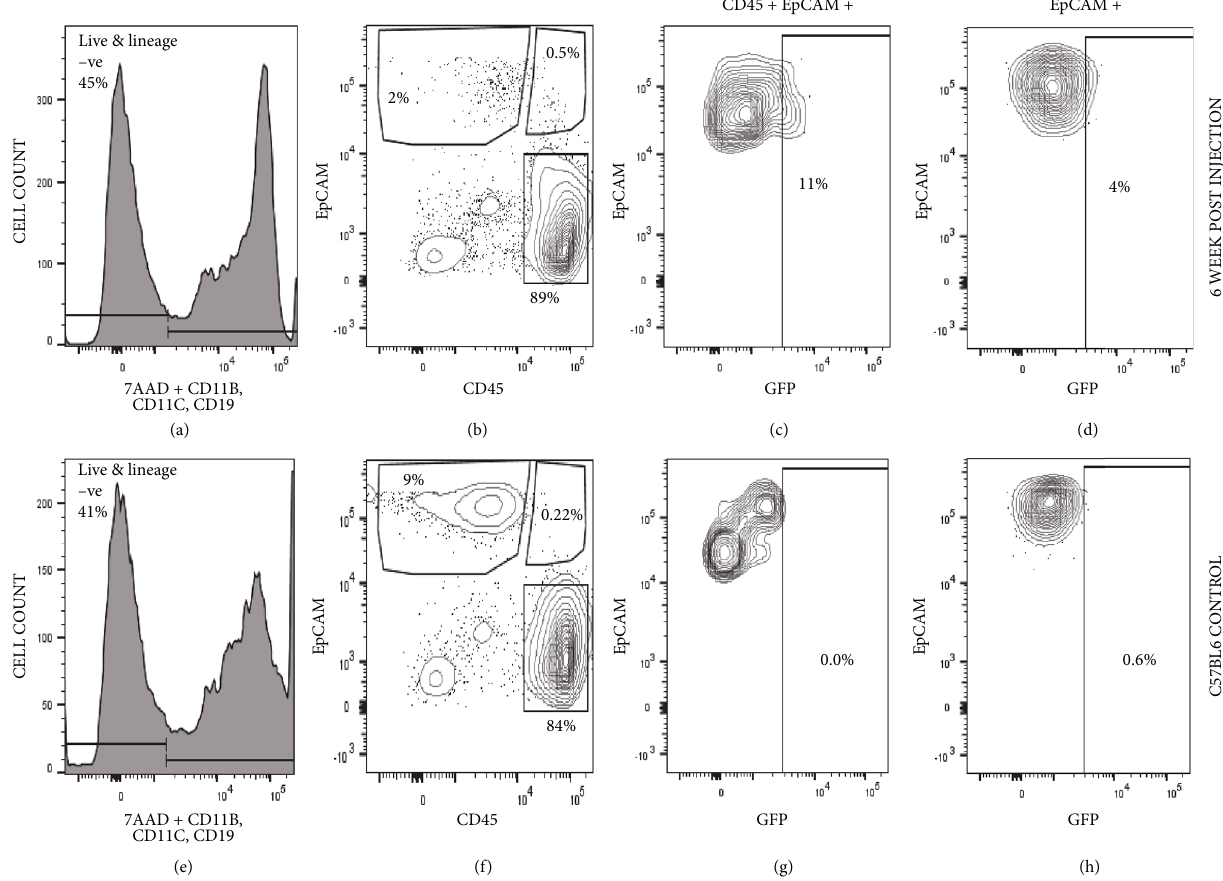
Figure 10: Bone marrow-derived CD45+ EpCAM+ cells can migrate to the thymus and contribute to the thymic CD45+ EpCAM+ population, as well as CD45- EpCAM+ TECs under the condition of radiation-induced injury. CD45+ EpCAM+ GFP+ cells were sorted to greater than 99% purity from actin H2BGFP mouse bone marrow and intravenously injected into partially irradiated C57BL6 mice. The thymus was then dissociated and analyzed for the presence of GFP-expressing cells 6 weeks after transplant using FACS. (a) Representative FACS pro fi le of the lineage-depleted cells derived from dissociated irradiated and injected thymus showing the gating strategy used analysis of live, lineage-negative cells. (a, b) The FACS representation of the lineage-depleted cells derived from dissociated irradiated and injected thymi gated for live and lineage-negative cells. (b) Representative FACS pro fi le showing CD45 and EpCAM expression within the viable lineage-negative cells from (a) and the gating strategy used for the analysis of the CD45+ EpCAM+ and CD45-EpCAM+ subsets subsequently analyzed for GFP expression in (c) and (d). (c) Representative FACS pro fi le showing the percentage of EpCAM+ GFP+ cells within the CD45+ EpCAM+ subset found in the thymus postirradiation and injection of DP cells and (d) representative FACS pro fi le showing the percentage of EpCAM+ GFP+ cells within the CD45- EpCAM+ subset found in the thymus postirradiation and injection of DP cells (e – f). Identical analysis to that (a – d) above using dissociated thymus from irradiated control non-GFP-expressing C57BL/6 mice to allow proper gating on H2BGFP+ cells. (e) Gating used for viable lineage-negative dissociated thymic cells. (f) Representative FACS pro fi le showing CD45 and EpCAM expression within the viable lineage-negative cells from (e) and the gating strategy used for the analysis of the CD45+ EpCAM+ and CD45- EpCAM+ subsets subsequently analyzed to allow proper gating for GFP expression in (g) and (h). (g) The FACS representation of the control gate for GFP-expressing cells within the CD45+ EpCAM+ subset found in the irradiated thymus and (h) the FACS representation of the control gate for GFP-expressing cells within the CD45- EpCAM+ subset found in the irradiated thymus. Four replicates of these experiments were